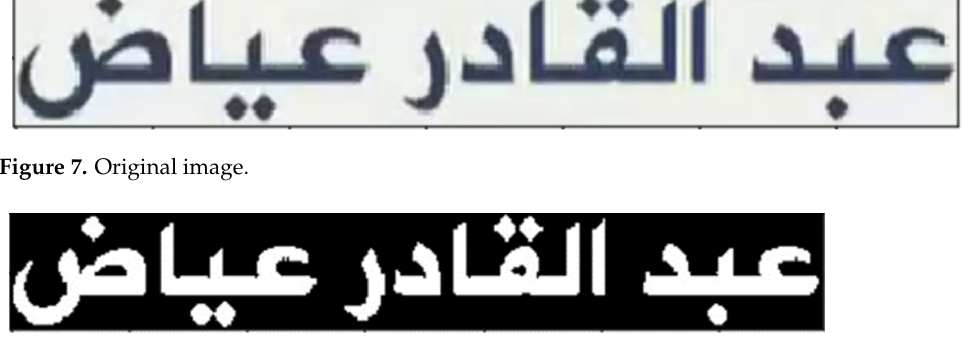
Figure 8. Binary image.